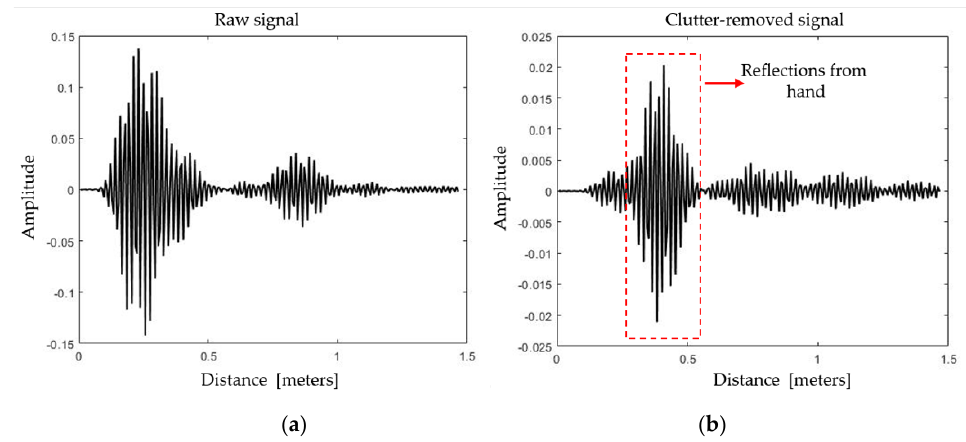
Figure 12. Single dimensional clutter removal operation: ( a ) input and ( b ) output of the clutter removal filter.